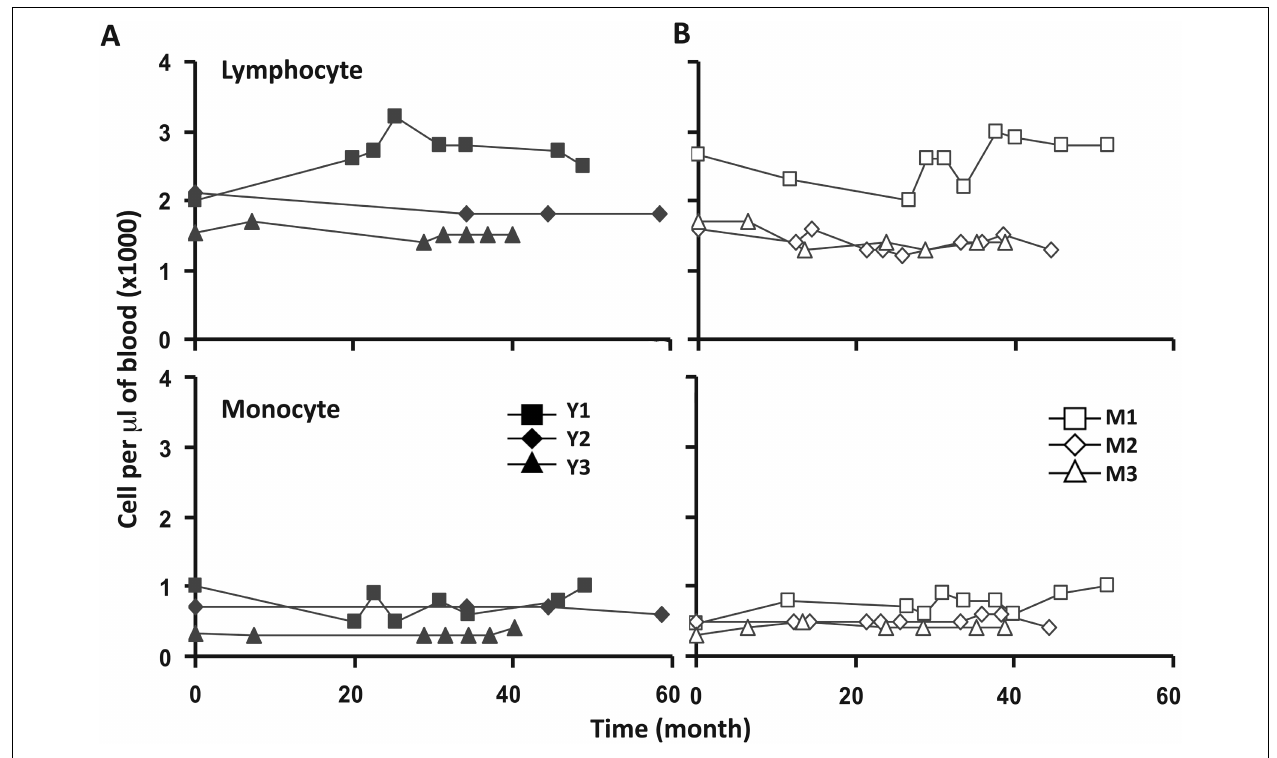
FIGURE 1 | Lymphocyte and monocytes counts were stable in peripheral blood of six frequent leukapheresis donors throughout 3–5 years. Six normal donors described in Table 1 were leukapheresed every other month over the course of 3–5 years. Lymphocyte (top panels) and monocyte (bottom panels) counts in peripheral blood were determined as part of a